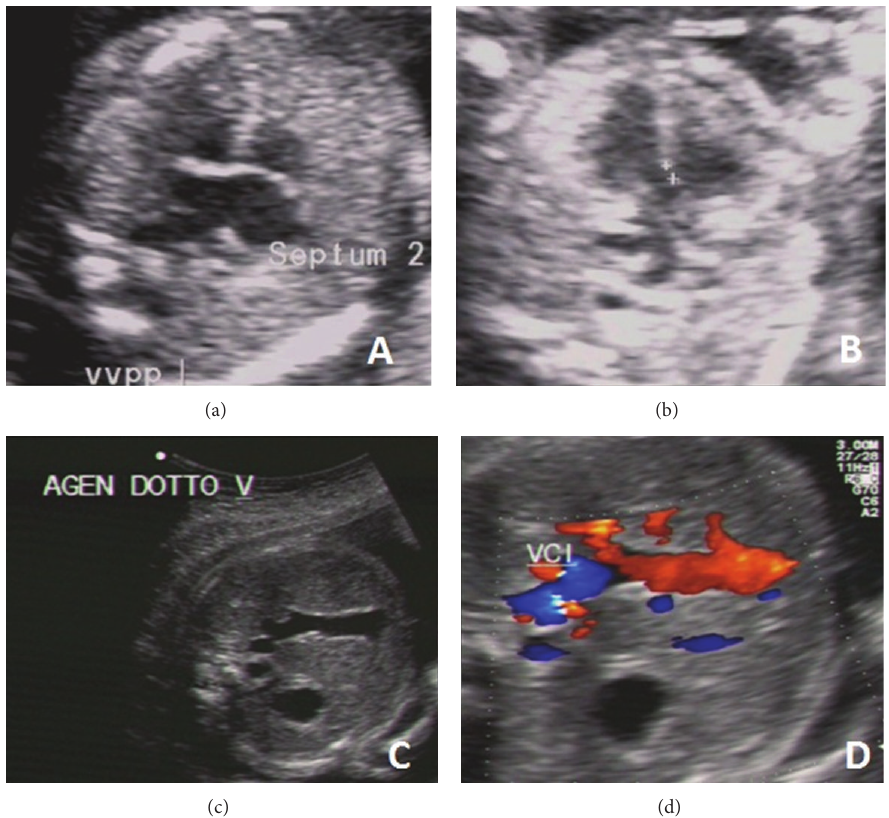
Figure 1: Prenatal ultrasonographic foetal heart anomalies detected at 19 ((a) ostium primum ASD; (b) perimembranous VSD) and 28 ((c)-(d) agenesis of the venous duct) weeks of pregnancy.